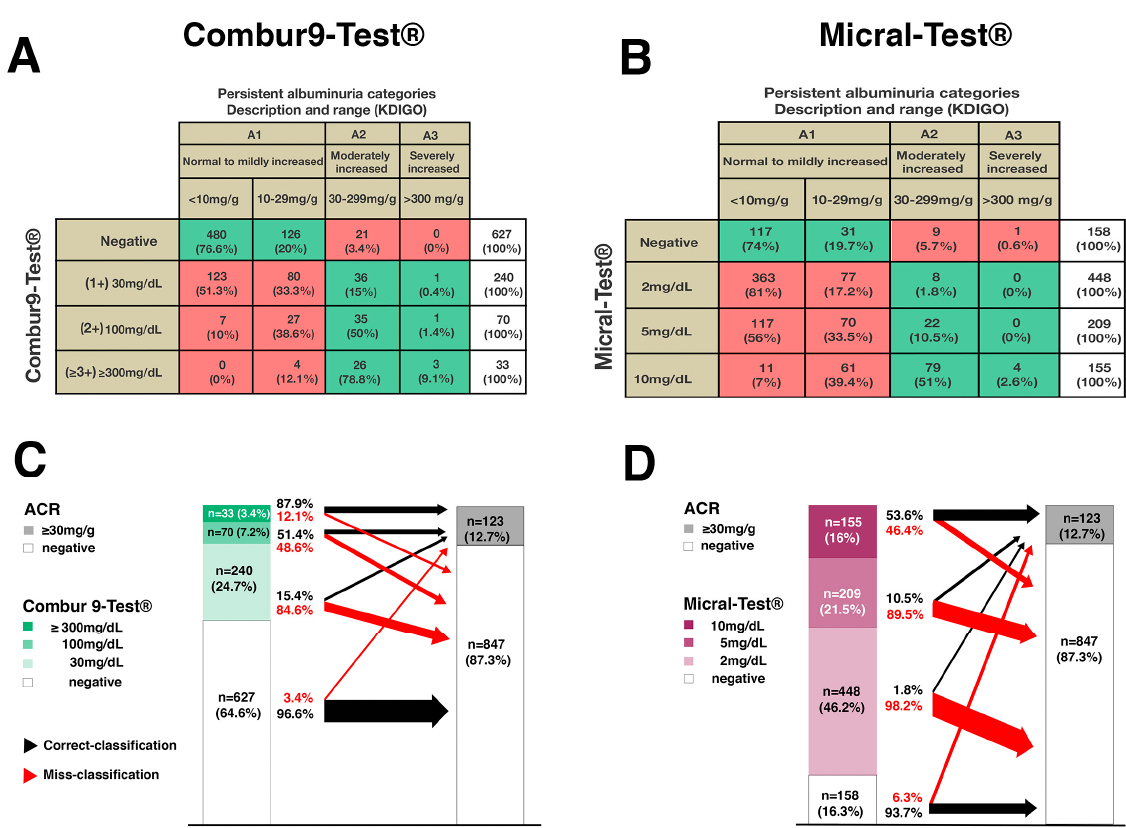
Figure 3. Distribution within KDIGO albuminuria classification: albuminuria stages A1: normally to mildly increased (<10–29 mg/g), A2: moderately increased (30–299 mg/g), A3: severely increased ( ≥ 300 mg/g); green areas: true-negative and true-positive classifications; red areas: false-positive and false-negative classifications; ( A ) total disagreement (red areas) and agreement (green areas) between index test (Combur9-Test ® ) and ACR test in n = 262 (27%) and n = 708 (73%), respectively; ( B ) total disagreement (red areas) and agreement (green areas) between index test (Micral-Test ® ) and ACR test in n = 709 (73%) and n = 261 (27%), respectively. ( C , D ): agreement/disagreement of ( C ) Combur9-Test ® and ( D ) Micral-Test ® with ACR at a cut-off of 30 mg/g: black arrow: agreement; red arrow: disagreement; arrow widths are proportional to the percentage of agreement/disagreement; KDIGO: Kidney Disease Improving Global Outcome [13]; ACR: albumin-to-creatinine